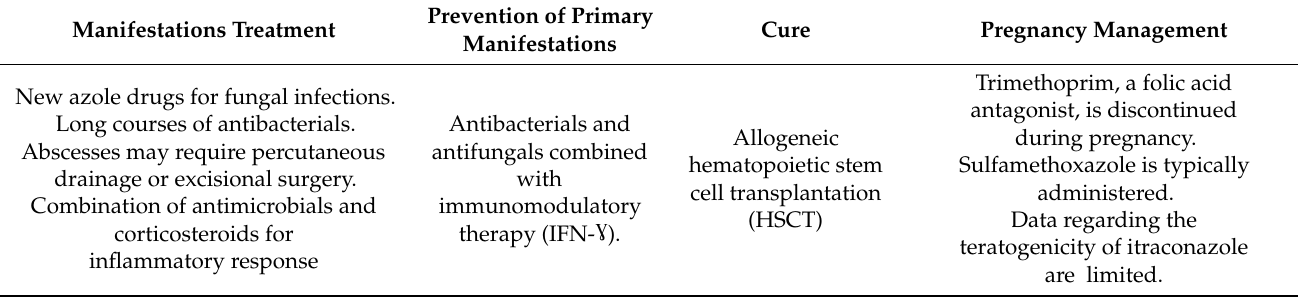
Table 2. Clinical management of CGD.